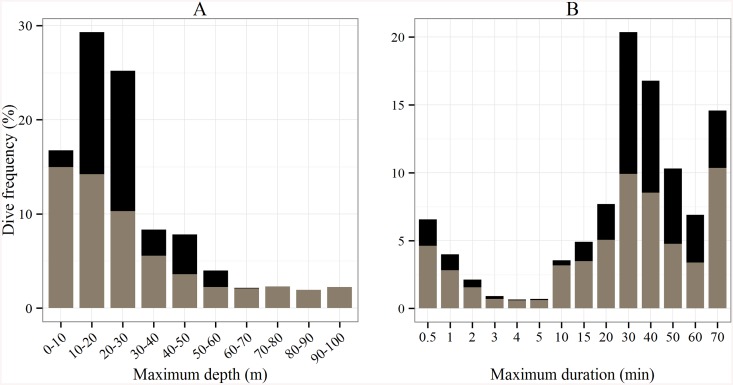
Histograms of (A) the maximum dive depth (m) and (B) the maximum dive duration (min) recorded by the 14 Argos-Fastloc GPS tags for the two behavioral modes, i.e. transiting (gray) and foraging (black).